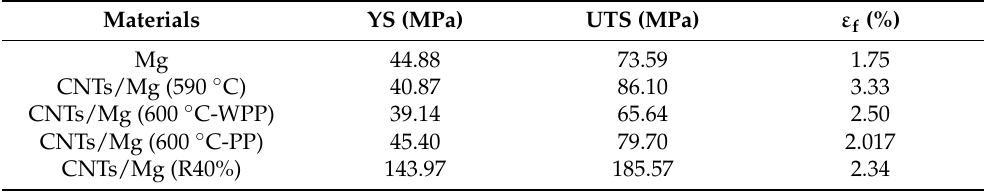
Figure 5. Engineering tensile stress – strain curves of rolled CNTs/Mg composites and CNTs/Mg composites. Table 1. Mechanical properties of Mg and laminated CNTs/Mg composites.